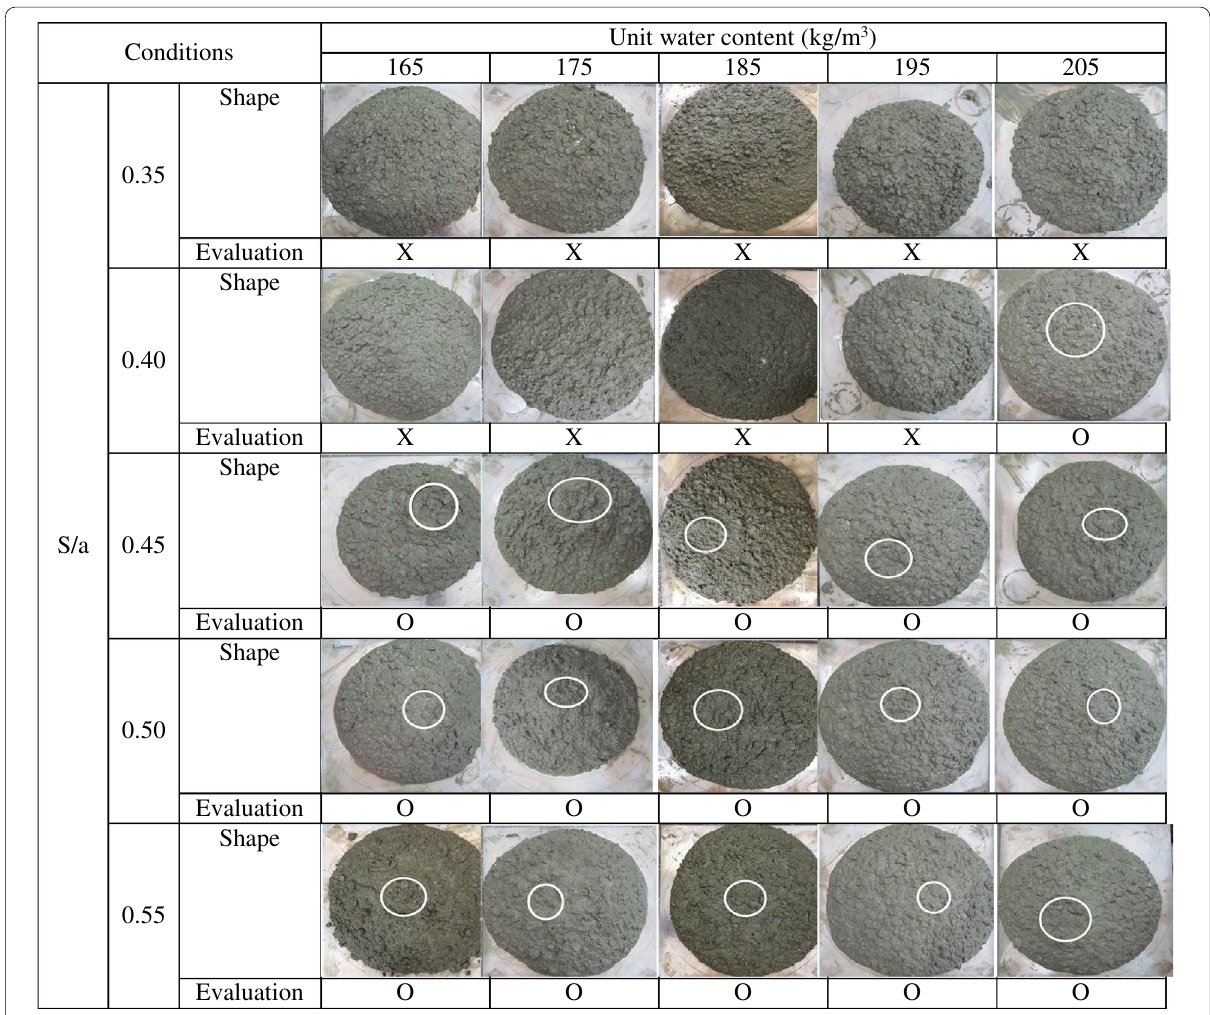
Fig. 13 Evaluation of segregation of high‑strength concrete mixtures by Maruya et al. method. The segregation evaluation was also conducted by the same method, and the circles on the concrete show the consistently appearing circle